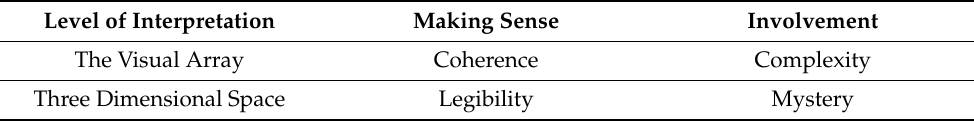
Table 1. Four factors of preference matrix (Source: Kaplan,